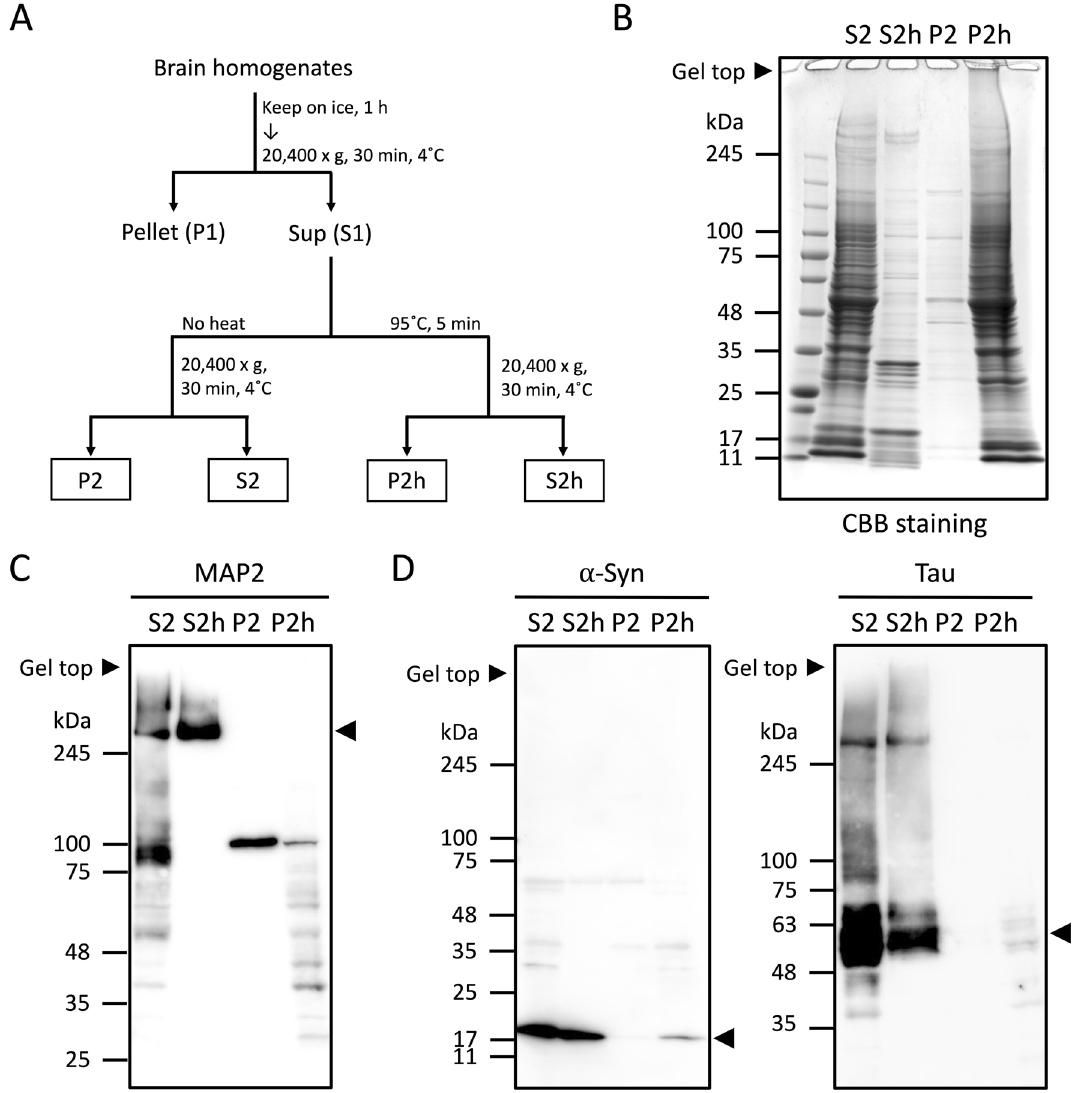
Figure 1. Purification of heat-stable proteins. (A) Mouse brains were subjected to subcellular fractionation. ( B) Equal amounts of fractions were subjected to SDS-PAGE and stained with CBB. ( C) Western blot of each fraction stained with anti-MAP2 antibody. (D) Western blot of each fraction stained with anti- ⍺ -syn and anti- tau antibodies. Arrowheads indicate the representative bands of each